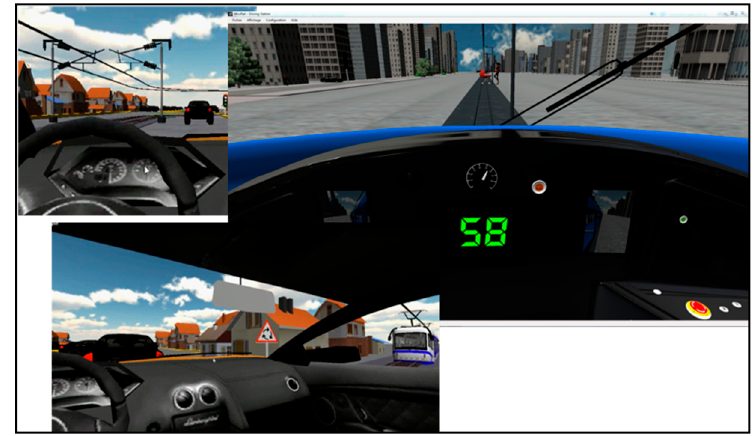
Figure 7. Train, car and pedestrian control simulation on MISSRAIL ® .